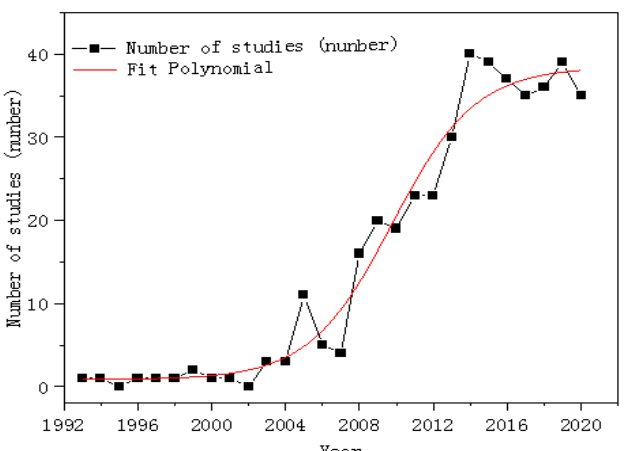
Figure 1. Distribution of water and fertilizer coupling and quality improvement in the literature by year.